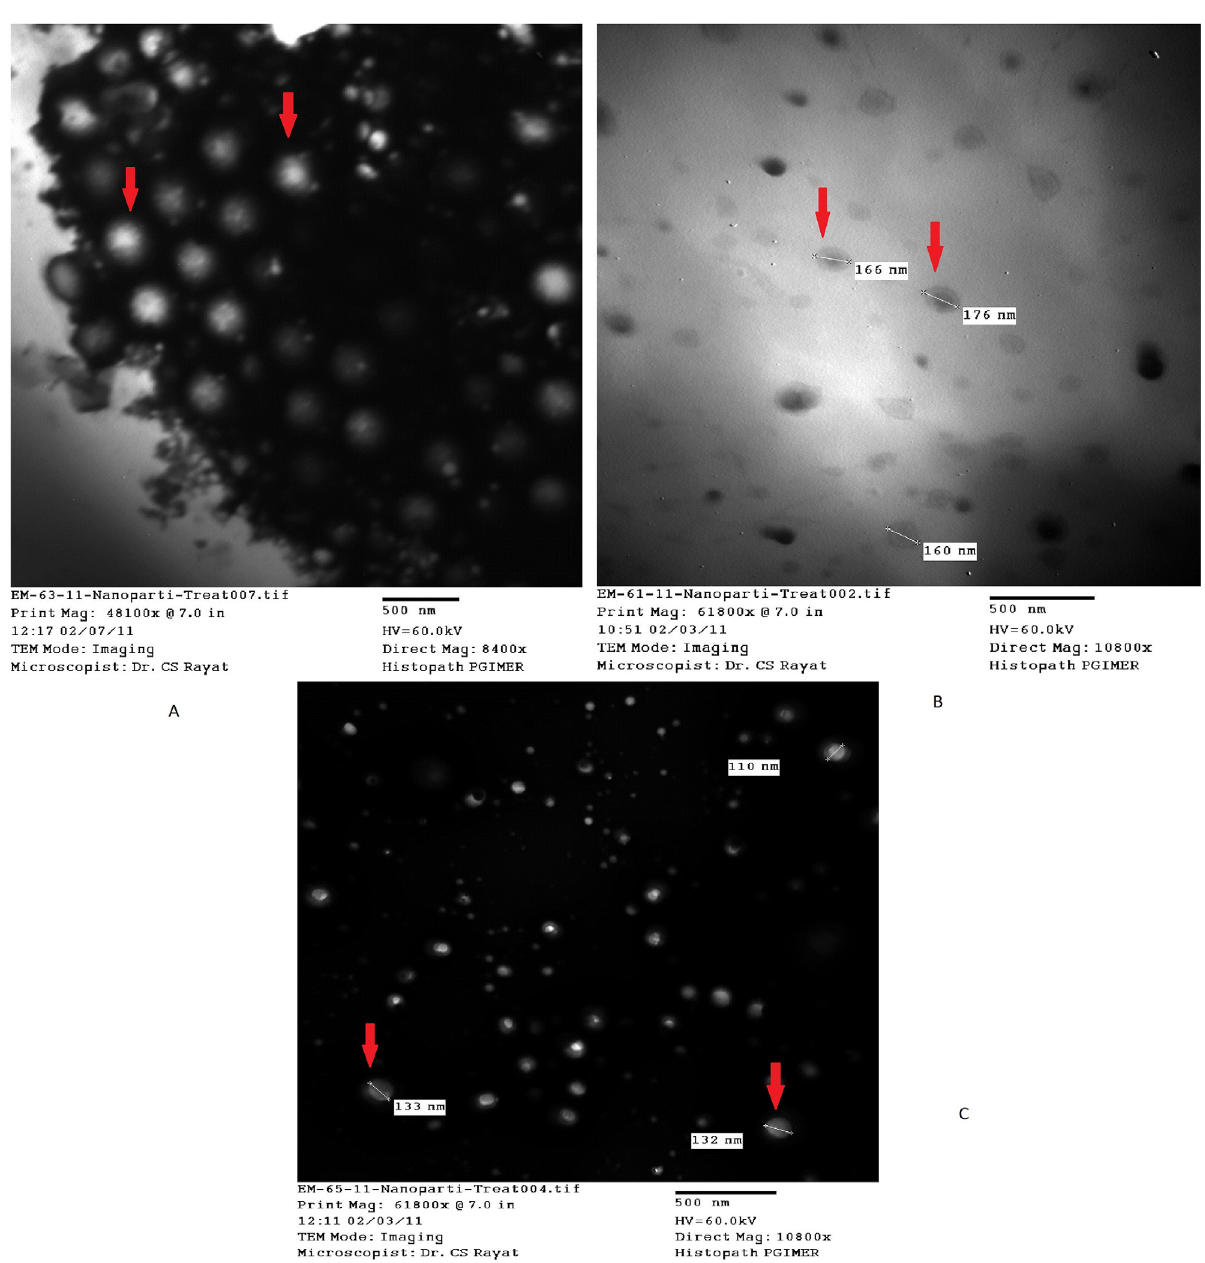
Fig 1. TEM images of (a) amlodipine (b) hydrochlorothiazide and (c) candesartan